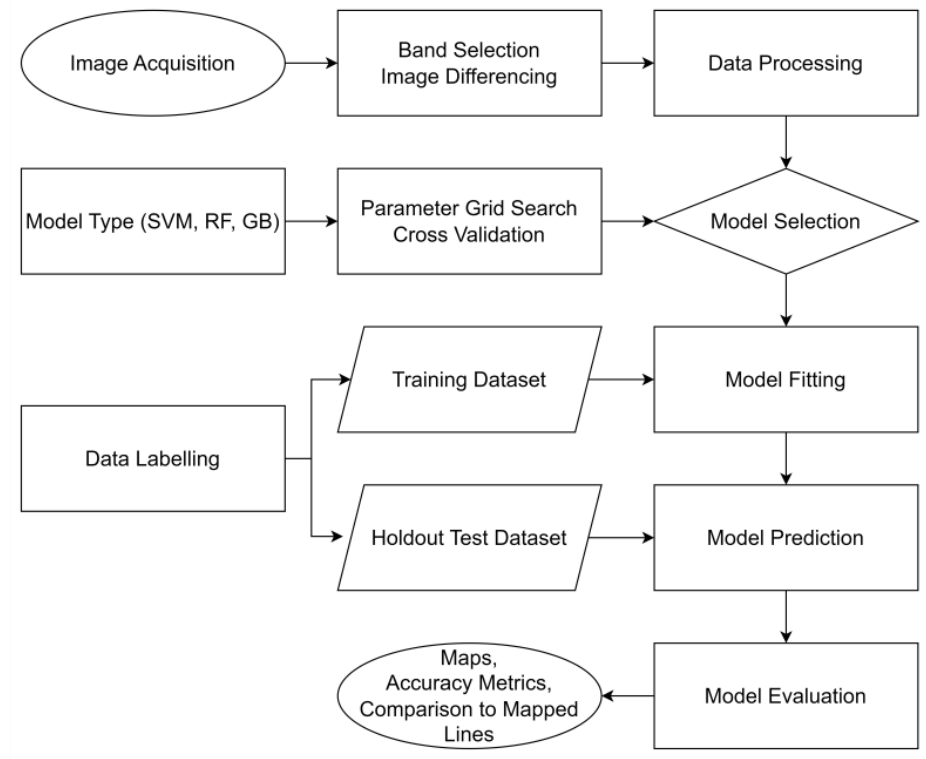
Figure 2. The model workflow implemented in this study (SVM = support vector machine; RF = random forest; GB = gradient boosting).